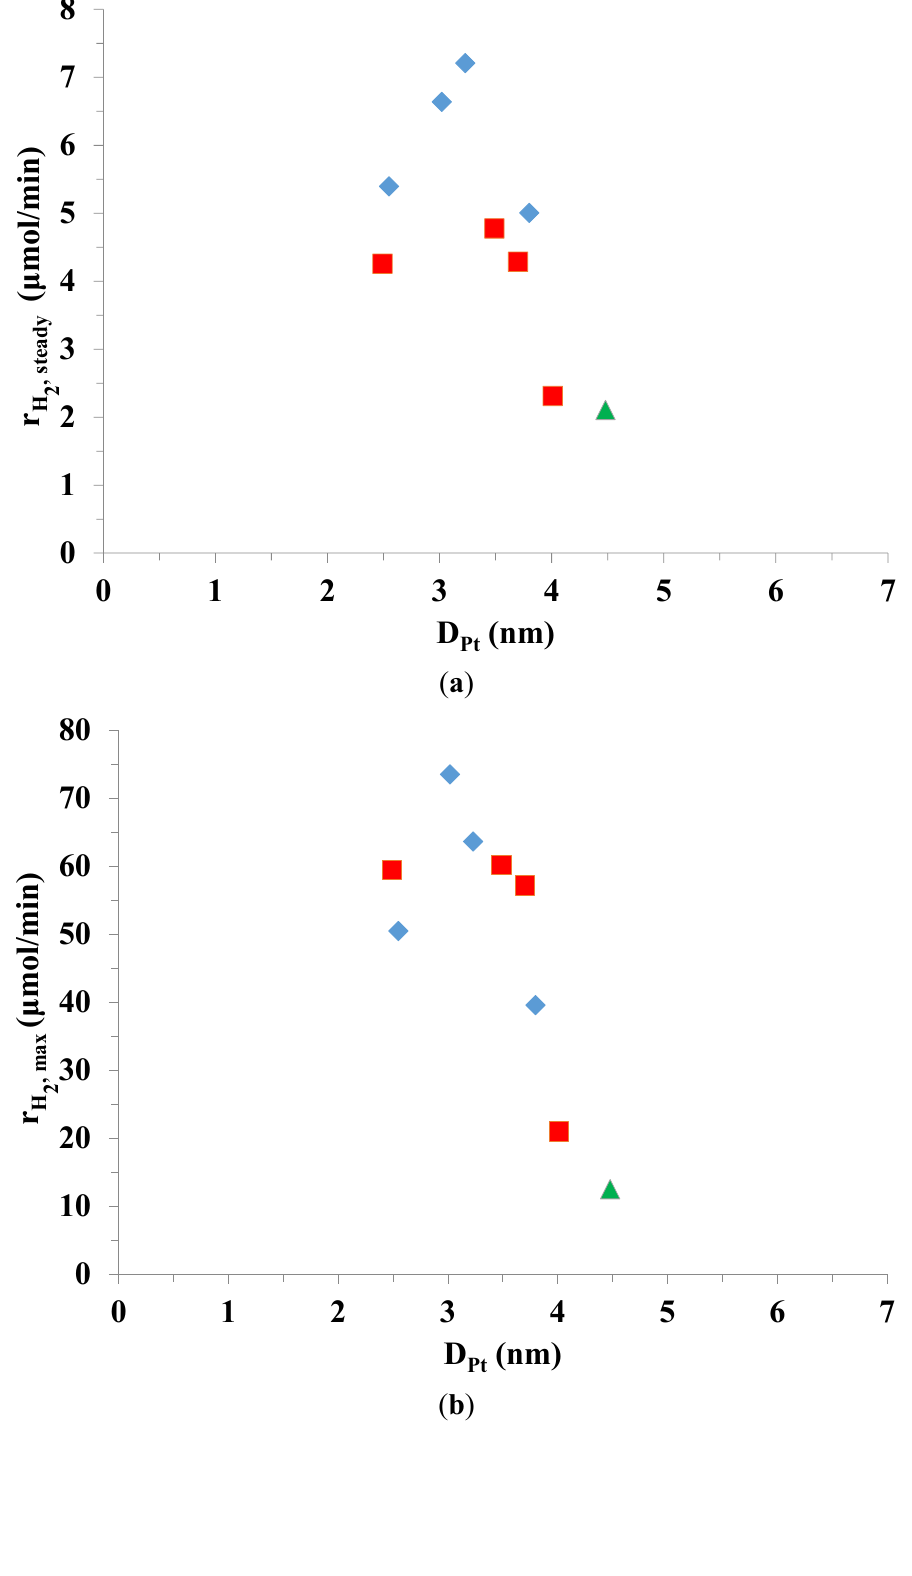
Figure 6. Comparison of H 2 evolution rates ( a ) steady state and ( b ) maximal as a function of D Pt on photoreduced (▲) and chemically reduced (CRIS (  ) and CRSIM (■)) Pt-TiO 2 photocatalysts using 50 mM oxalic acid as sacrificial